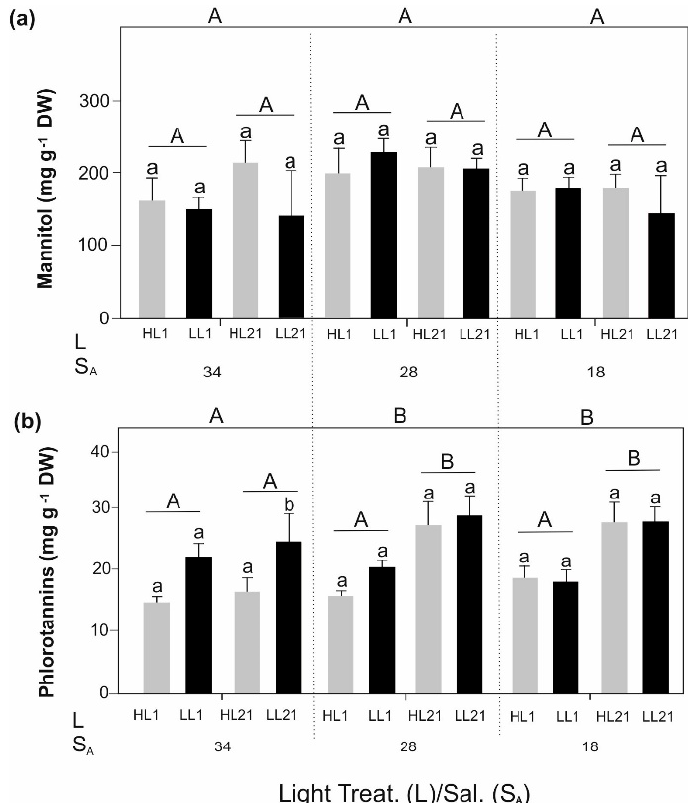
Figure 1. Concentration in mg g − 1 dry weight (DW) for compounds in Desmarestia aculeata : ( a )